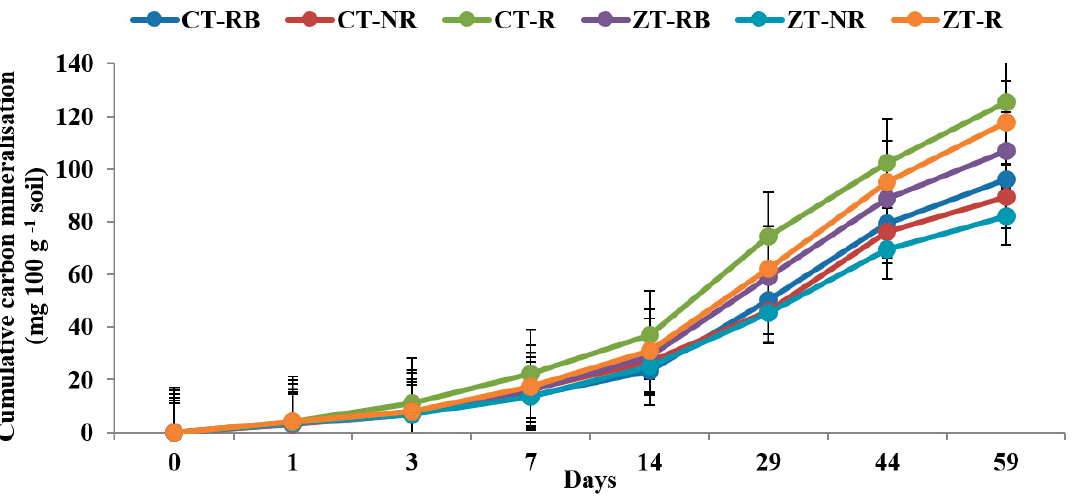
Figure 3. Cumulative carbon mineralization (mg 100 g − 1 soil) from macro-aggregate in 0–5 cm depths as affected by 18 years of tillage and residue management in a rice–wheat cropping system in an Inceptisol at 37 °C. ZT = zero tillage; CT = conventional tillage; NR = no residue; RB = residue burning; R = residue retention. Error bars identify LSD ( p ≤ 0.05) of different treatments.